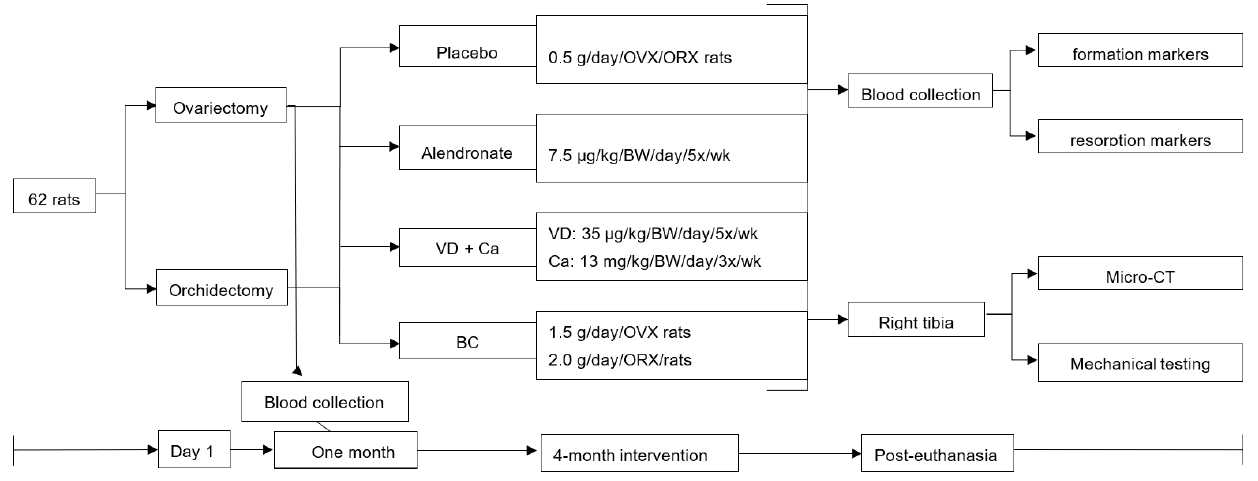
Figure 1. OVX= ovariectomized; ORX = orchidectomized; VD = Vitamin D; Ca = calcium; BC = bovine colostrum; BW = body weight; wk = week.